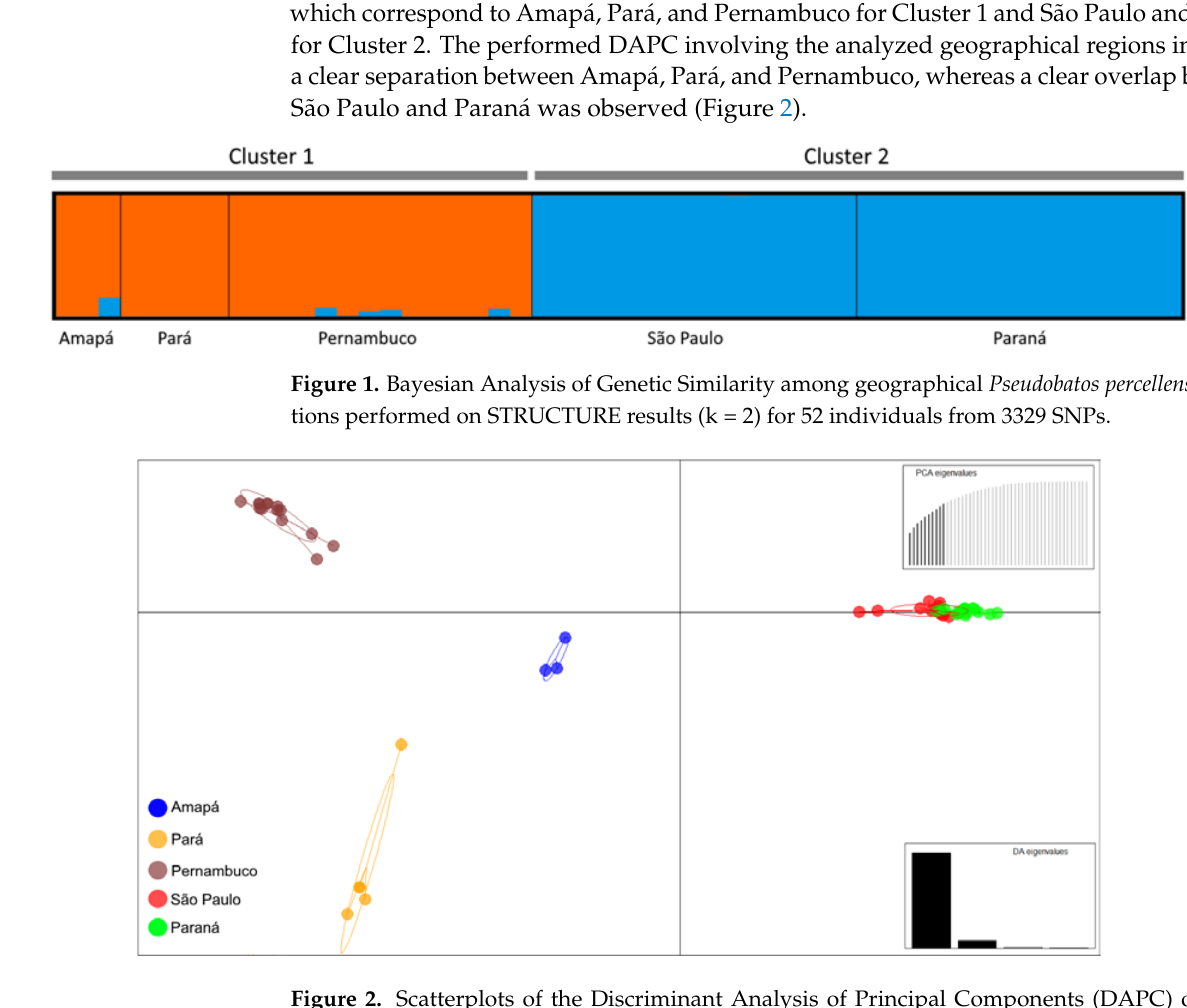
Figure 2. Scatterplots of the Discriminant Analysis of Principal Components (DAPC) om 3.329 SNPs from Pseudobatos percellens . Dots represent individuals and colored ellipses correspond to geographical populations. The Principal Component Analysis (PCA) and DA (Significance tests) eigenvalue representatives are highlighted in the inset.